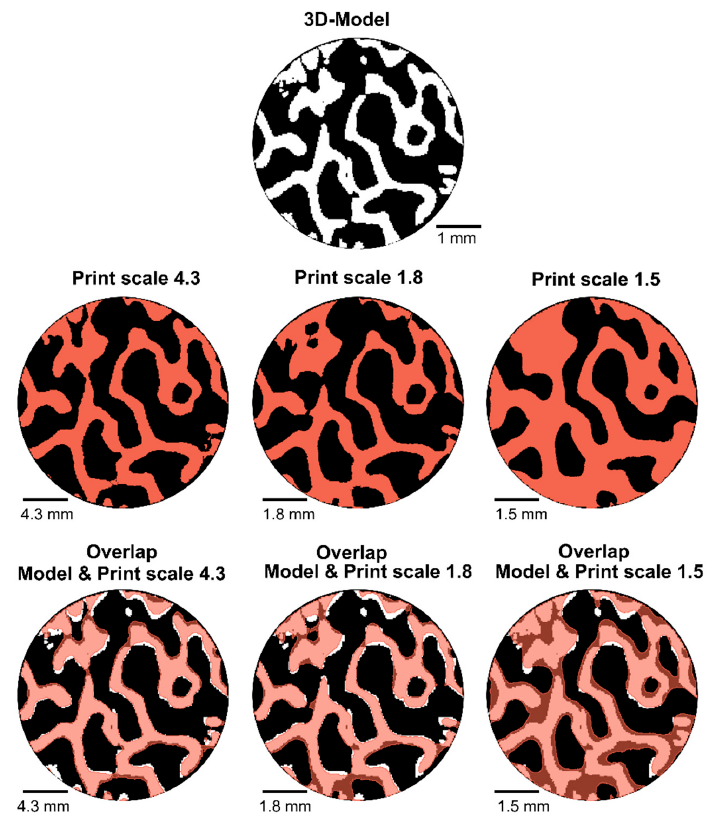
Figure 6. Cross-sectional comparison of registered micro-CT images from the model and the printed parts. The model is displayed in white ( first row ) and the printed parts of different scales are displayed in red ( second row ). An overlap comparison is seen in the bottom rows, where the printed cross-sections are superimposed over the model. For this comparison, the model ( white ) was scaled up to the scale of the displayed printed part ( red ).